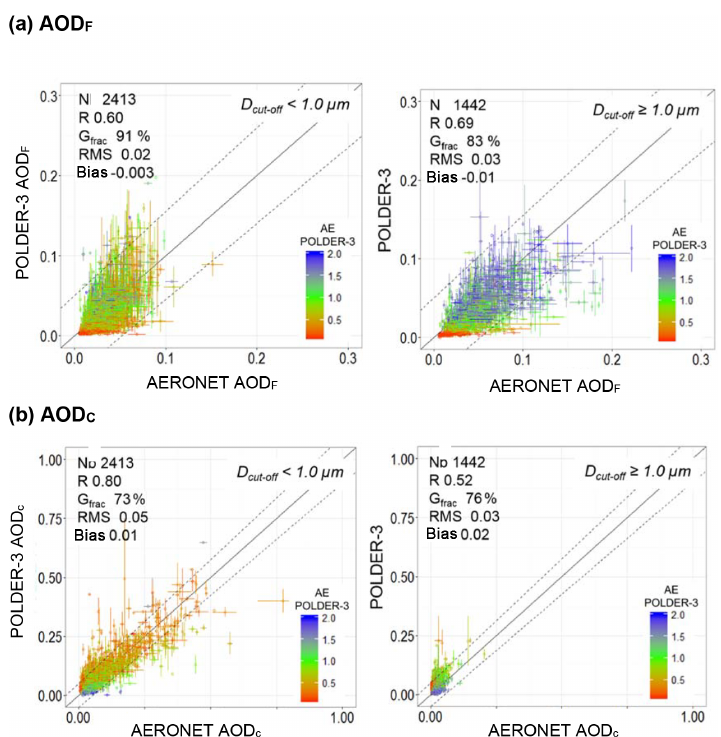
Figure 5. Scatter plots of daily AOD F (a) and AOD C (b) retrieved by POLDER-3 at 865nm as function of coincident AERONET values at 870nm at the 17 sites of the western Mediterranean Sea. The AERONET AOD F and AOD C are calculated from the fine and coarse modes of the retrieved volume size distribution defined as below and above a threshold diameter ( D cut-off ) corresponding to the minimum of the size distribution. The D cut-off is not fixed but can vary between 0.44 and 0.99µm. The figure presents cases corresponding to AERONET retrievals yielding a separation of the fine and coarse modes of the volume distribution at D cut-off < 1 . 0µm (left) and days with AERONET D cut-off ≥ 1 . 0µm (right). The solid line is the bisector. The dashed lines represent the limits indicated by the G frac parameter. The characteristics of the linear correlation (number of points N , correlation coefficient R , G frac , RMSE, and bias) are also